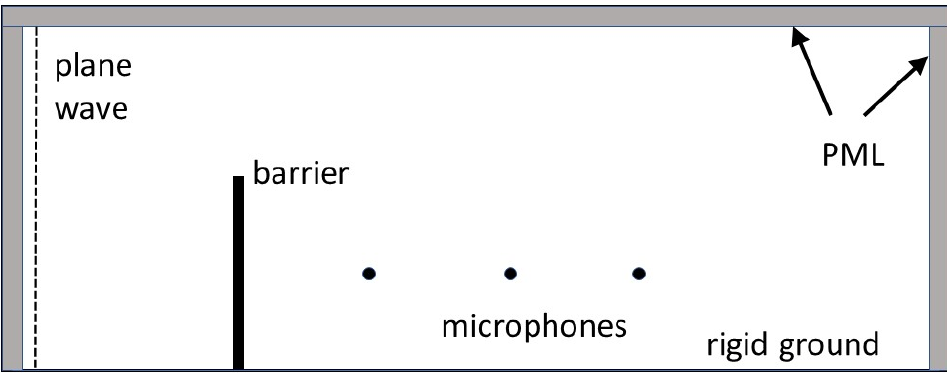
Figure 2. Schematic representation of the FDTD model, used in the XZ simulation, including indication of the considered boundary conditions.